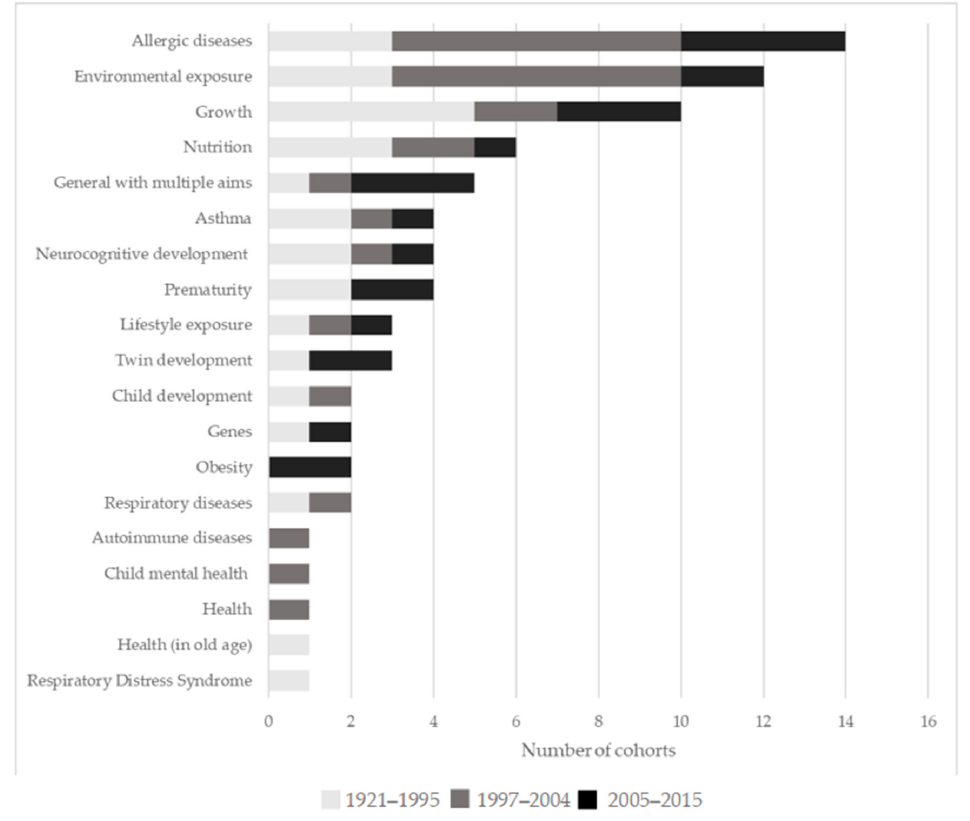
Figure 5. Frequency of scientific areas addressed by the cohorts, divided into three groups based on starting year of the cohort.